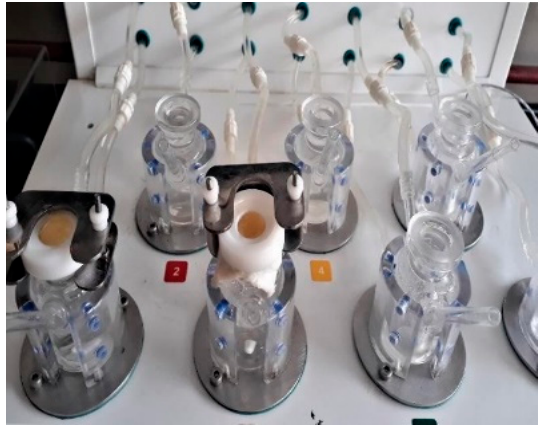
Figure 1 . Modified vertical Franz diffusion cell apparatus. Figure 1. Modified vertical Franz diffusion cell